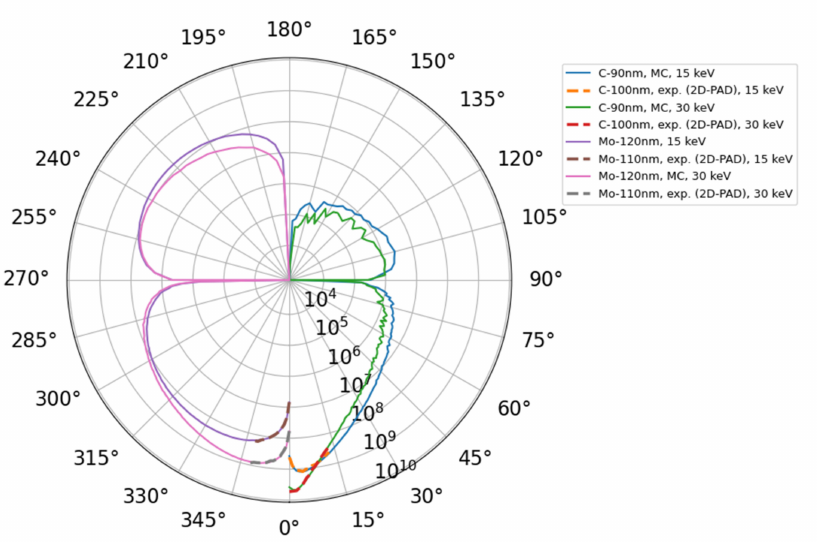
Figure 11. Polar plot of area-corrected and scaled experimental data (dashed lines) C 100 nm (right) and Mo 110 nm (left) for both 15 keV and 30 keV. The experimental data have been scaled to values of energy (solid lines) collected—within polar angle of step 1 deg—from MC simulations (10 6 electrons). Best-match thickness, i.e., glassy-carbon 90 nm and Mo 120 nm, was used. Thus, the scale of the “radial” axis reflects the energy dosage in eV enclosed within each polar angle